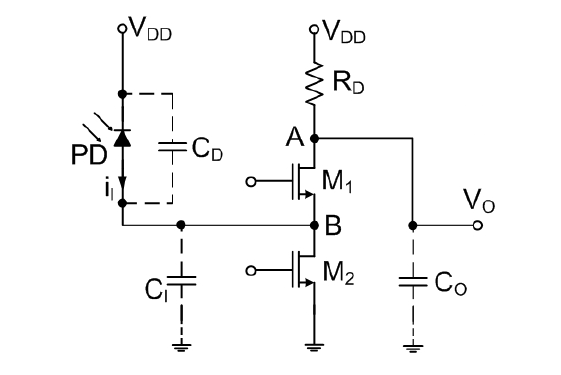
Figure 5. Common-gate